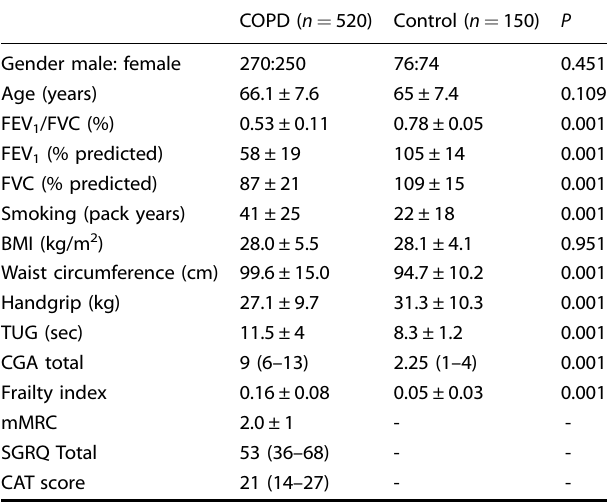
Table 1. Participants physical and clinical characteristics.